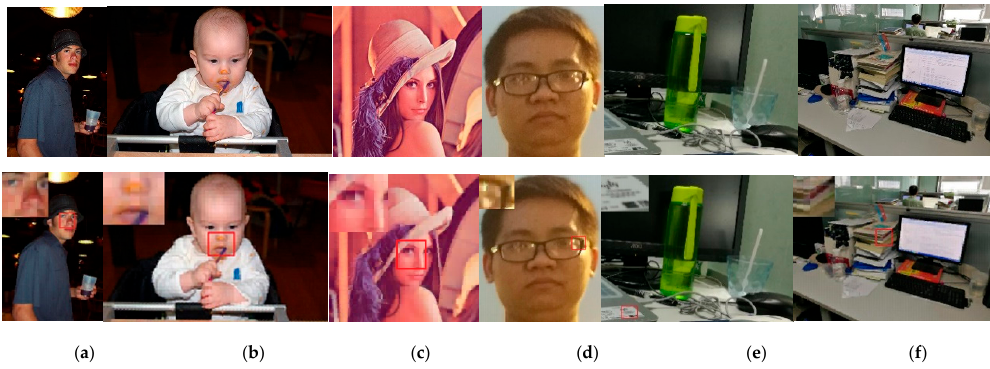
Figure 6. Direct feature visualization results. The upper row is the original image and the next row is the visualized image. ( a ) Man ; ( b ) baby ; ( c ) Lena ; ( d ) boy ; ( e ) desktop; ( f ) indoor .